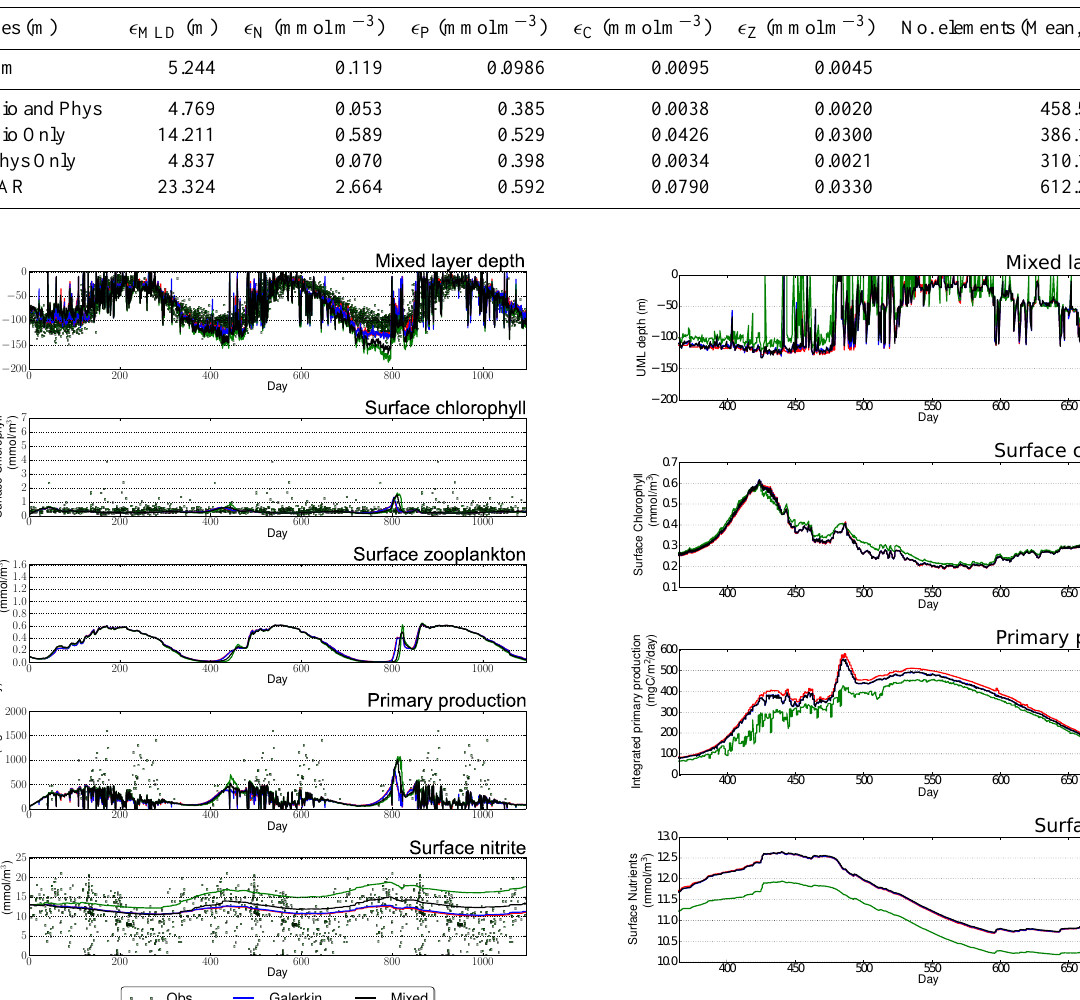
Table 5. The rms error, (cid:15) , of adaptive mesh simulations compared to the simulation with 2.5m vertical resolution at Station Papa. (cid:15) is shown for MLD, and the L2 norm of nutrient, primary productivity, chlorophyll and zooplankton. See Fig. 6 also.